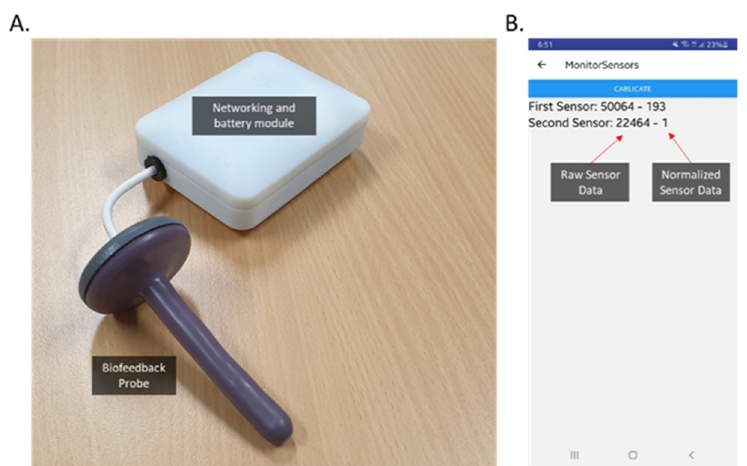
Figure 8. ( A ) The new IoMT sensing probe attached to networking/battery module. ( B ) The mobile app showing real-time output data from sensing probe. Raw sensor data and normalized values from first sensor (anal sphincter) and second sensor (rectal) are displayed.